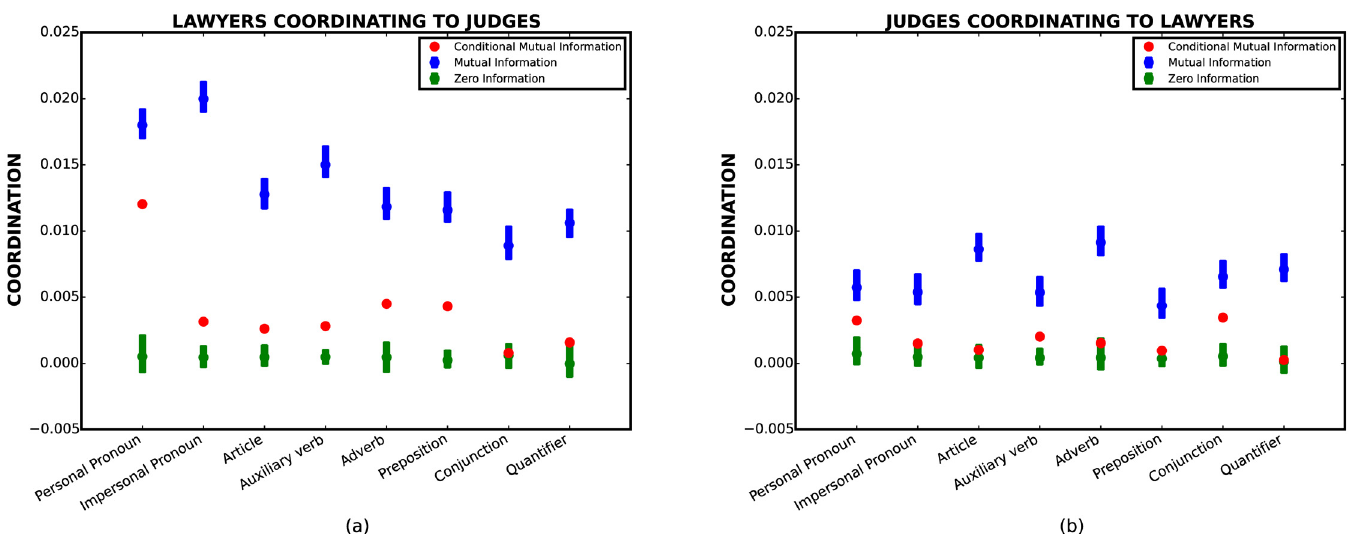
Fig 1. Coordination measures for the Supreme Court data. The red (blue) dots give the true CMI (MI). The green dots represent CMI under the null hypothesis that there is no coordination after conditioning. (a) Lawyers coordinating to Judges. (b) Judges coordinating to Lawyers. In both figures, the conditional mutual information is significantly smaller than the mutual information for all eight stylistic features, indicating length is a confounding